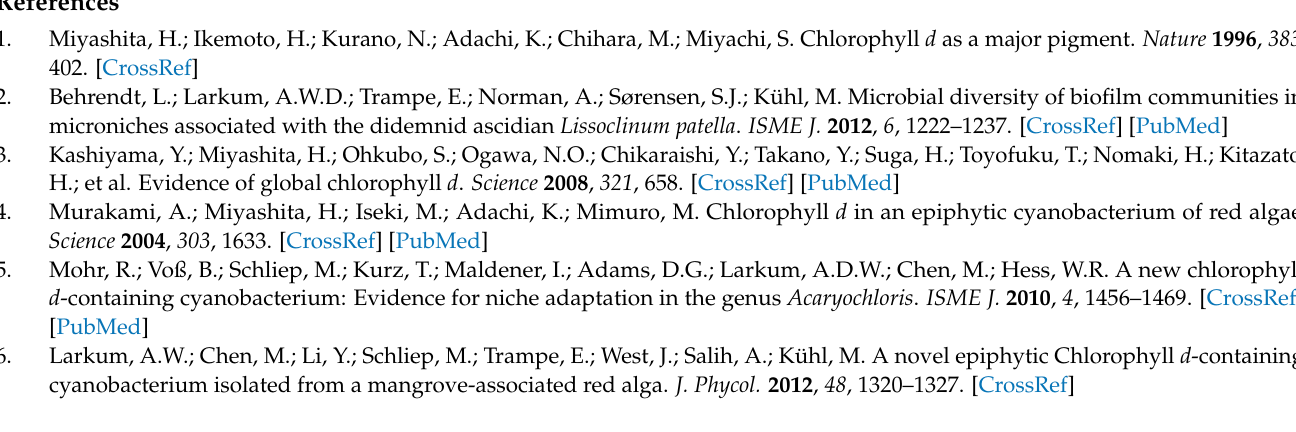
Euclidean distance. Table S1: Sampling information for A. marina strain collection, Table S2: Genome assembly statistics, Table S3: A. marina core genome, Table S4: Complete KEGG modules in the Acaryocloris marina core genome, Table S5: Genes unique to the A. marina core, Table S6: Summary of FeGenie results, Table S7: A. marina CRISPR arrays, repeat sequences and spacer numbers, Table S8: CRISPRTarget output for A. marina strain